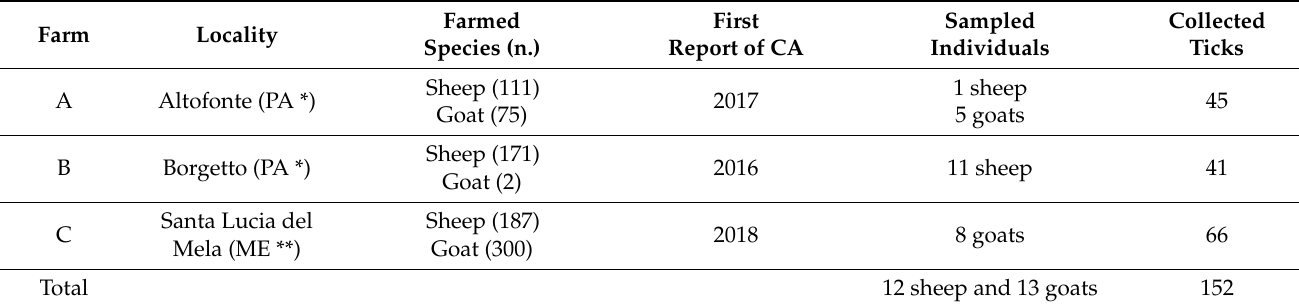
Table 1. Farm information and number of animals